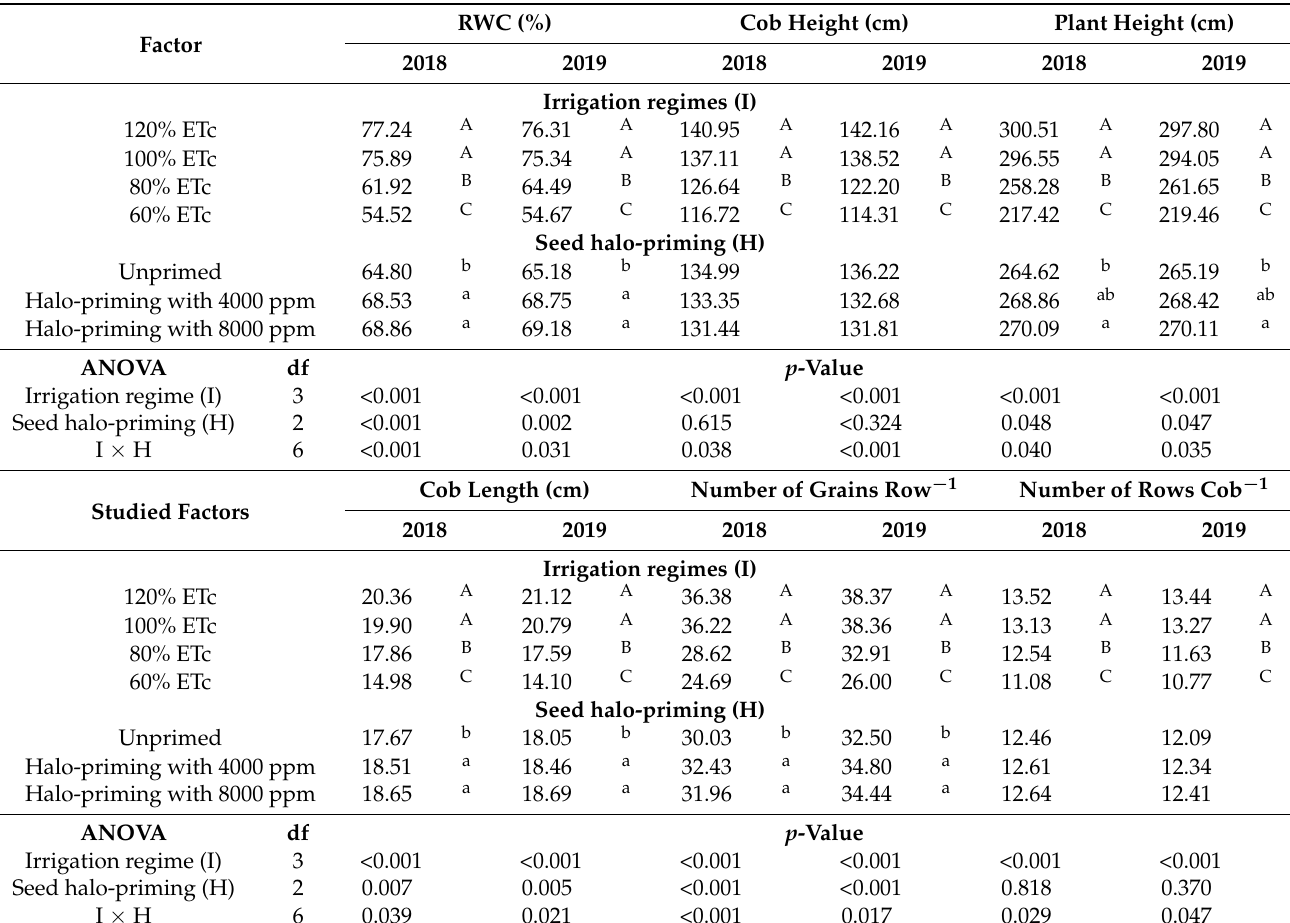
Table 4. Effect of irrigation regimes and seed halo-priming treatments on relative water content (RWC), cob height, plant height, cob length, number of grains row − 1 , and number of rows cob − 1 during two growing seasons of 2018 and 2019.